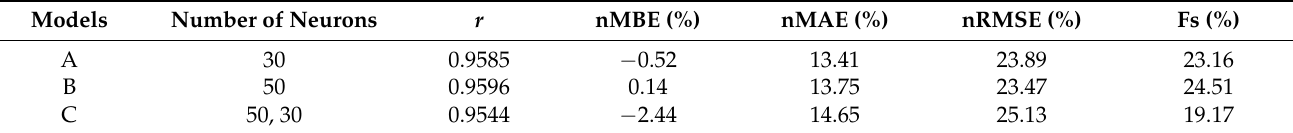
Table 4. The performance of the SCNN-LSTM model with different LSTM layers and numbers of neurons. Models